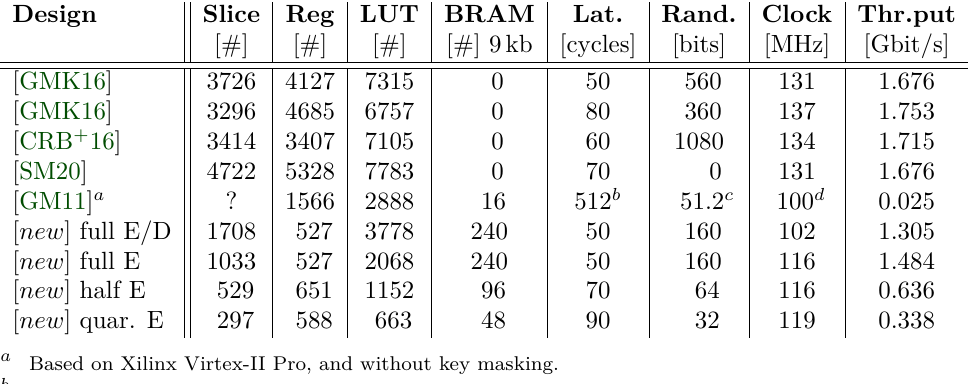
Table 1: Comparison of high-performance implementations excluding PRNG (with key masking, mapped on Xilinx